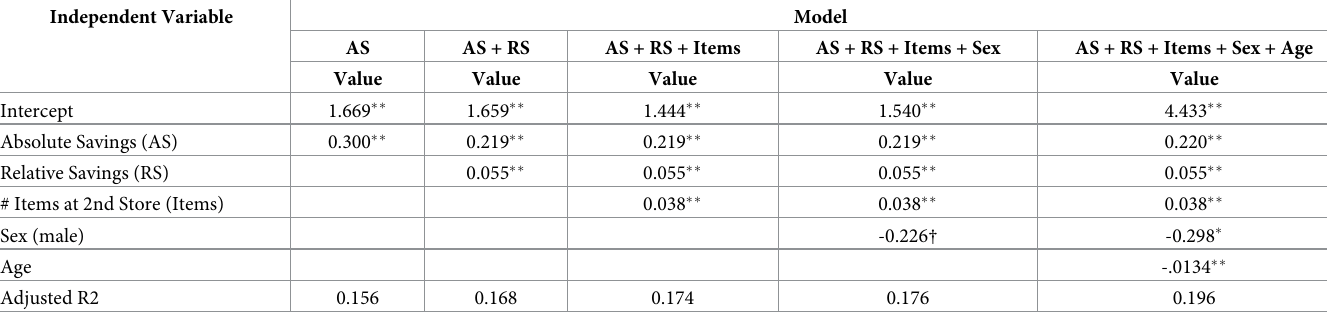
Table 6. Linear Regression results against likelihood (n = 808) (Study